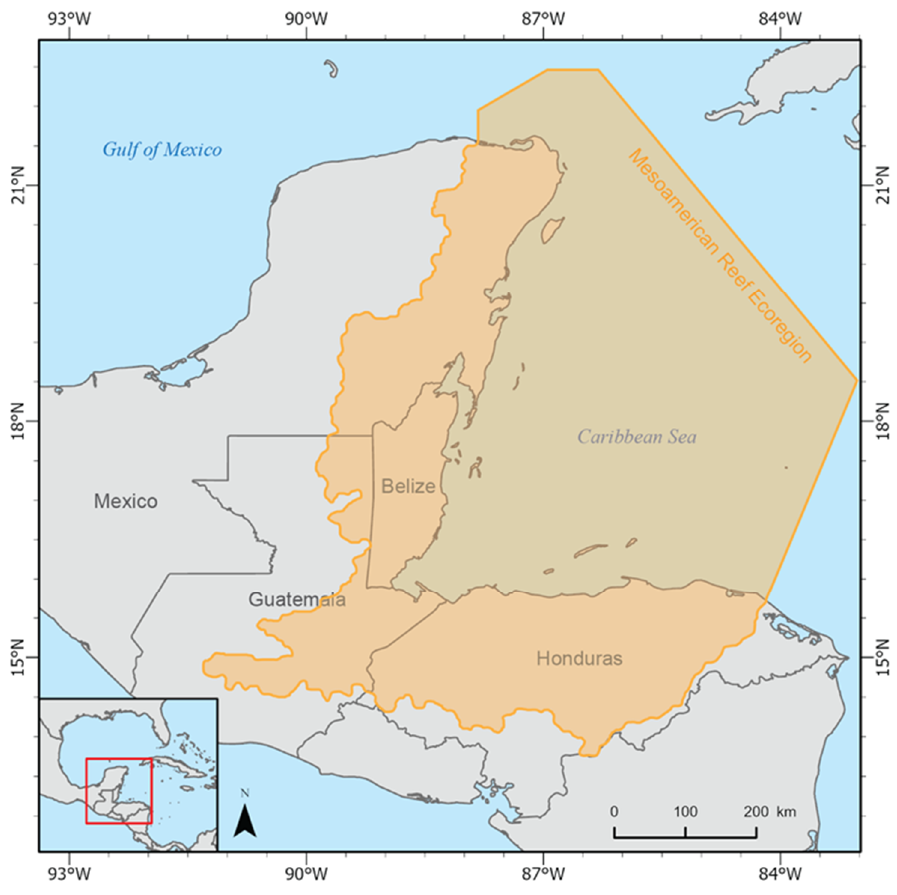
Figure 1. Map of Belize and its location within the Mesoamerican Reef ecoregion.